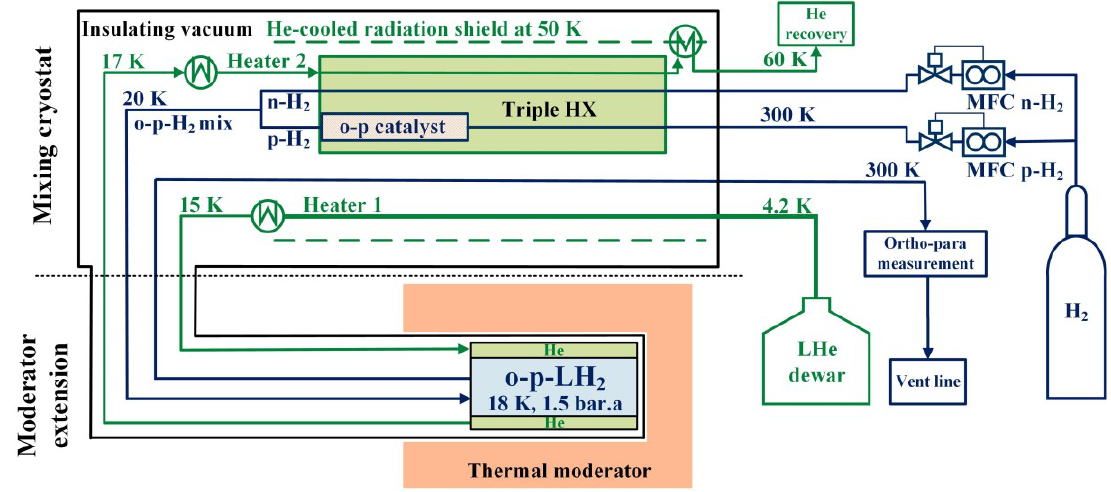
Figure 4. Schematic representation of the cryogenic